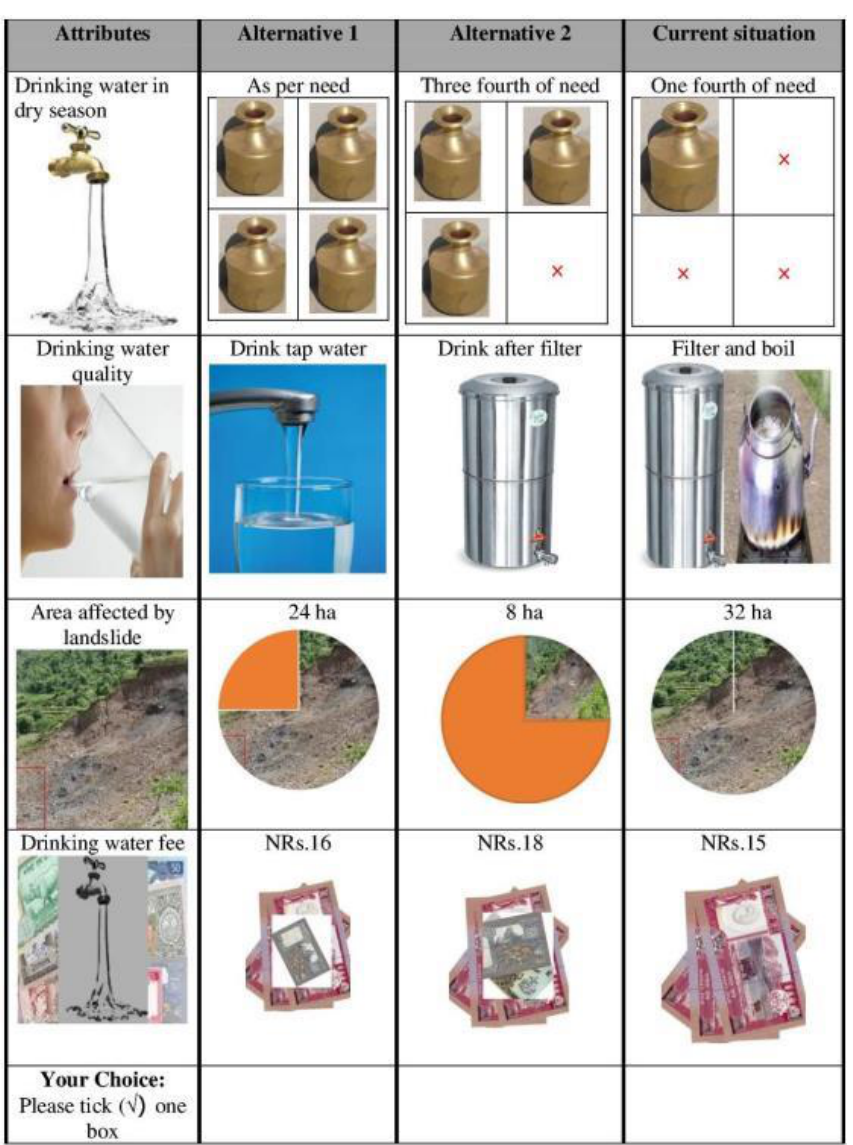
Figure 2. An example of a pictorial choice card presented to downstream households as part of the Discrete Choice Experiment.